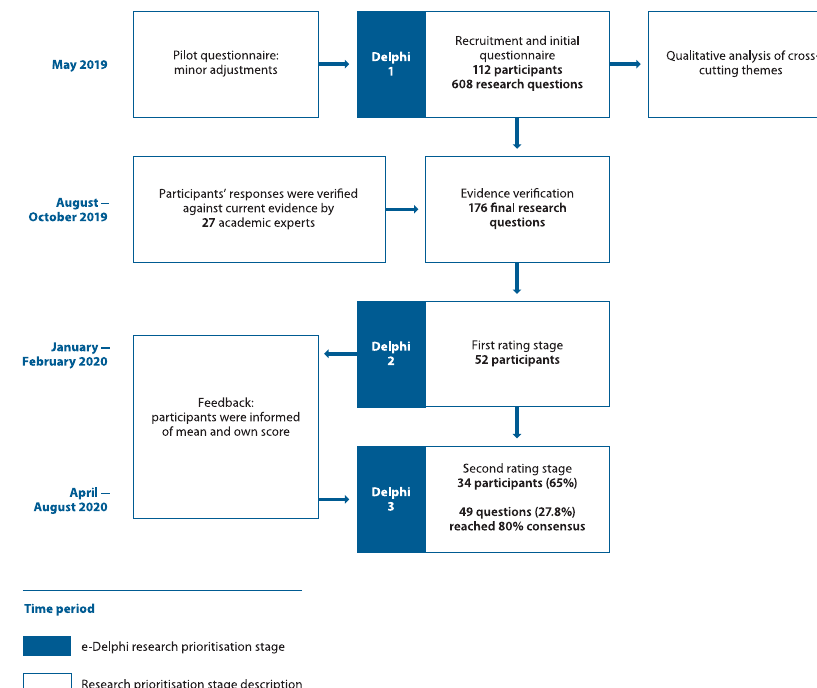
Fig. 1 Flow diagram of the research prioritisation